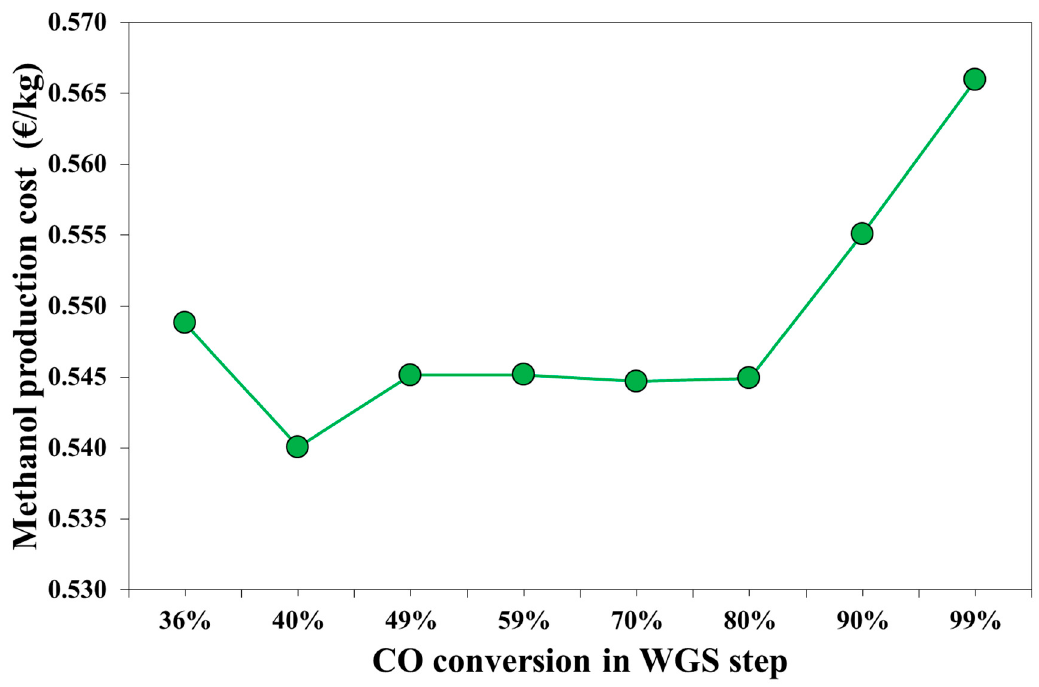
Figure 7. Cost of the upgraded syngas for methanol synthesis expressed in kmol of carbon atoms.